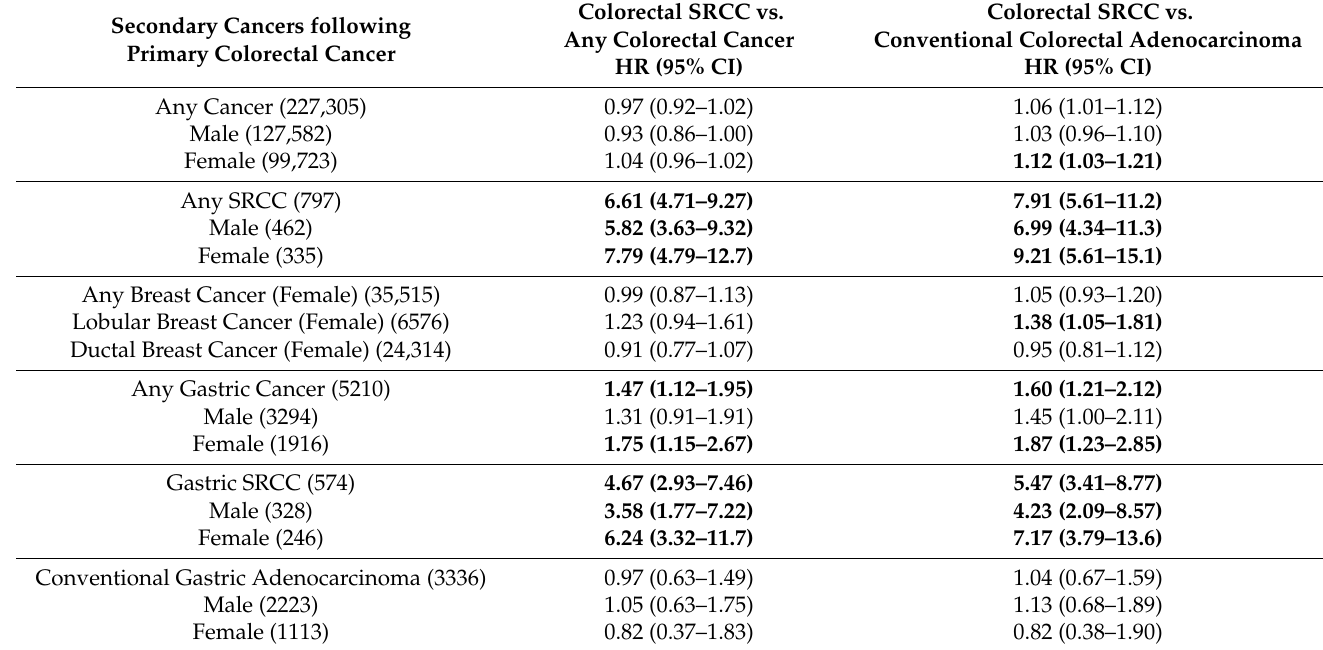
Table 6. Estimated hazard risk ratios (HR) with 95% confidence intervals (CI) for secondary cancers among patients with a primary sporadic colorectal SRCC compared to other patients with any other colorectal cancer type and conventional colorectal adenocarcinoma from SEER.